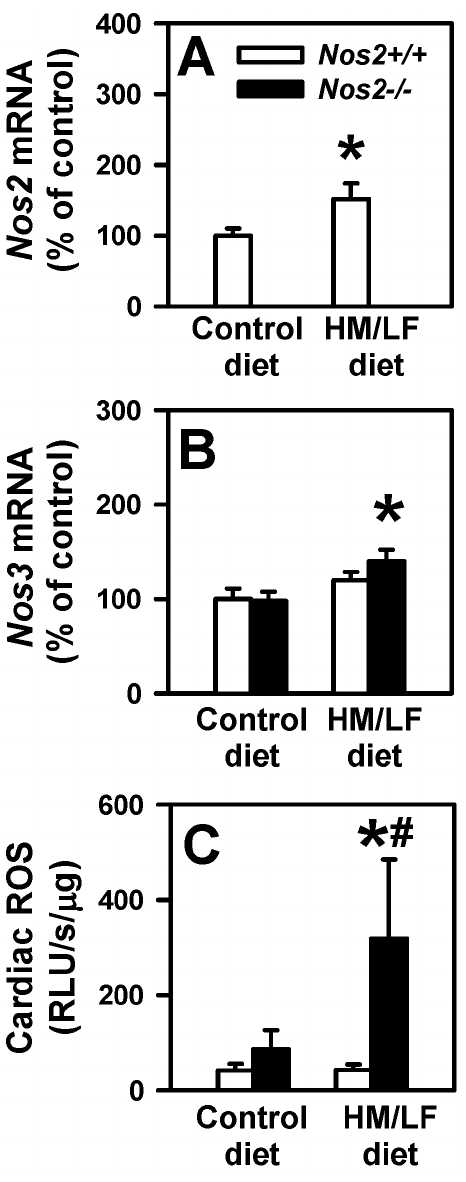
Figure 6. Cardiac levels of Nos2 and Nos3 mRNA and ROS. Levels of Nos2 mRNA (A) and Nos3 mRNA (B) were measured by real-time PCR in Nos2 + / + (open bars) or Nos2 2 / 2 (filled bars) mice. Values were normalized to 18S mRNA and are expressed as percent of the control values observed in Nos2 + / + mice fed the control diet. (C) Tiron- quenchable and NADPH-enhanced lucigenin chemiluminescence was measured in cardiac homogenates. Values are mean 6 SE. 6–9 mice were studied in each group. *P , 0.05 compared with mice of the same genotype fed the control diet; # P , 0.05 compared with Nos2 + / + mice fed the same diet.